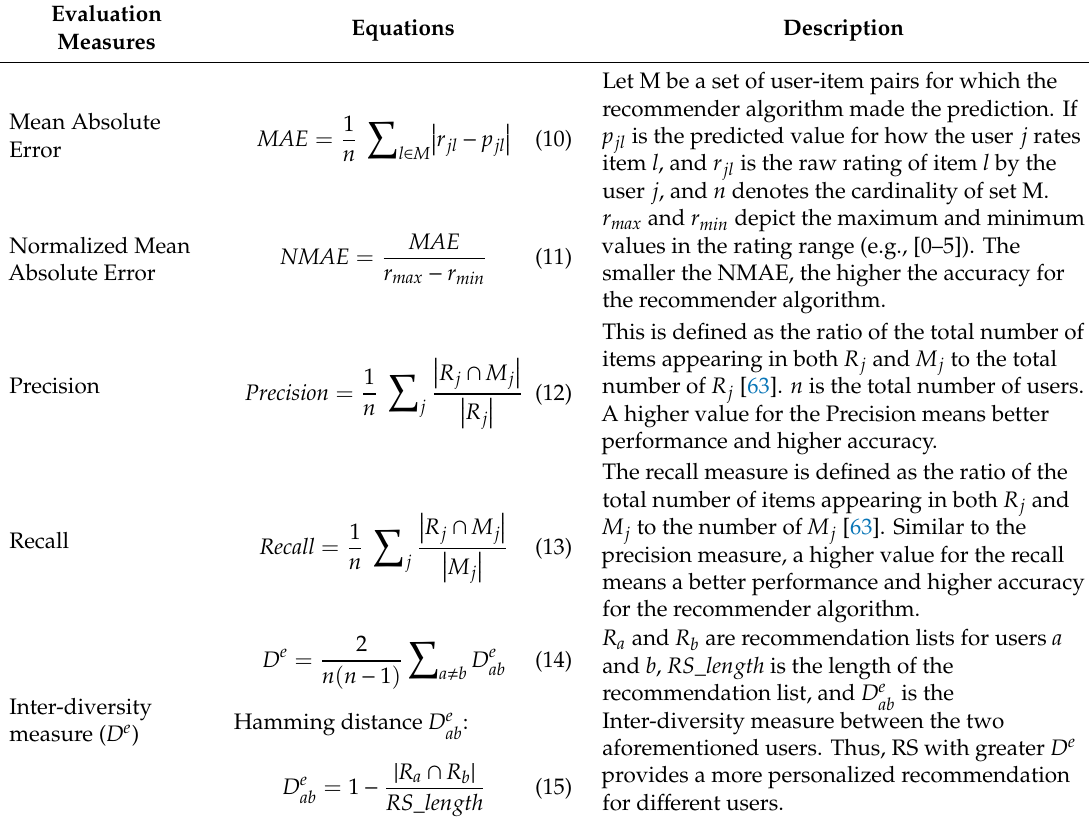
Table 9. Evaluation